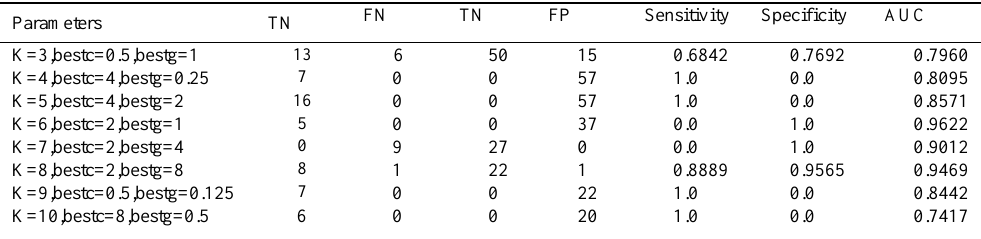
Table 2. K-fold CV results using the grid search for optimal parameters of C-SVM classifier.